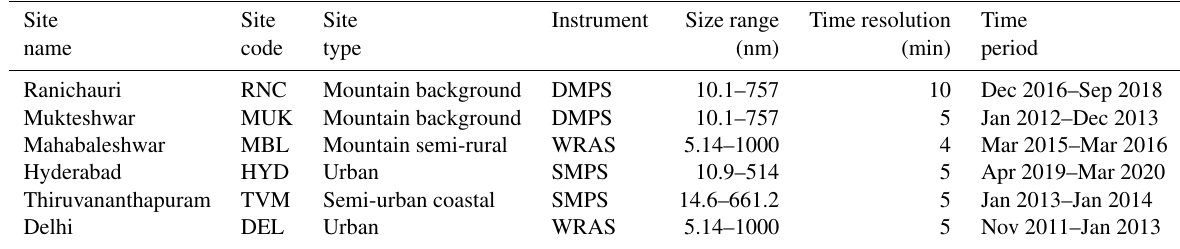
Table 1. Details of the measurement sites and particle number size distribution measurements analyzed in this study. Site Site